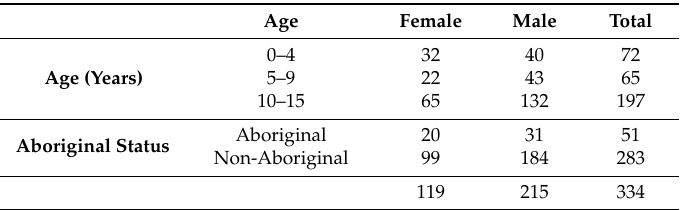
Table 1. Number of injury deaths by age, sex, and Aboriginal status.